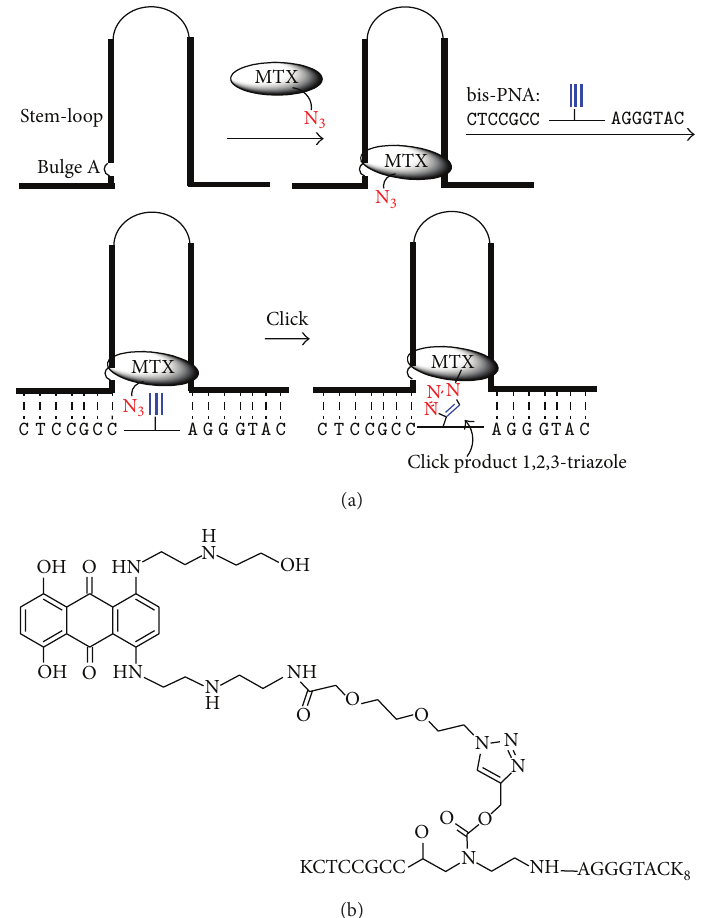
Figure 6: (a) Schematic of template-directed combinatorial strategy to identify MTX-PNA conjugates. MTX analogs containing a linker- azide combined bipartite PNA with a linker-alkyne in the presence of tau RNA oligonucleotide representing the stem-loop and flanking sequences. MTX and PNA analogs that bind well, with the proper distance and orientation between azide and alkyne, undergo cyclization to a 1,2,3-triazole. (b) MTX conjugated to bipartite PNA identified through template-directed combinatorial